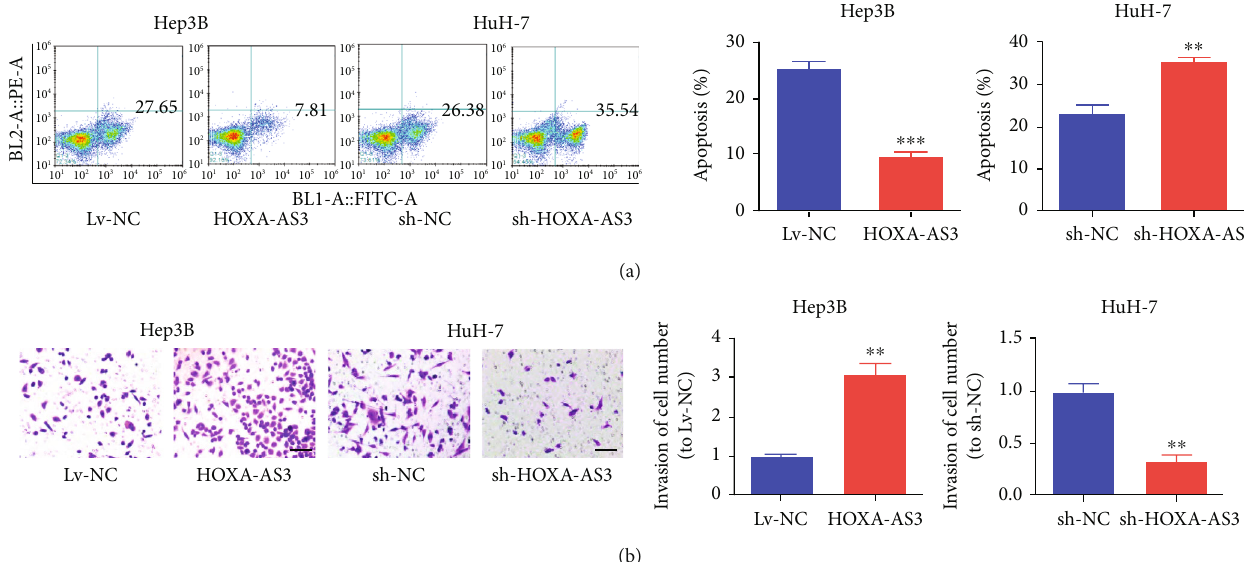
Figure 3: HOXA-AS3 upregulation promotes HCC cell invasion but inhibits cell apoptosis. (a) Apoptosis assay showing higher HOXA-AS3 level inhibits the apoptosis of HCC cells. (b) Transwell assay showing higher HOXA-AS3 level enhances the invasion of HCC cells ( bar = 100 μ m). Data are reported as the mean ± SD of three separate experiments; ∗∗ P < 0 : 01 and ∗∗∗ P < 0 : 001